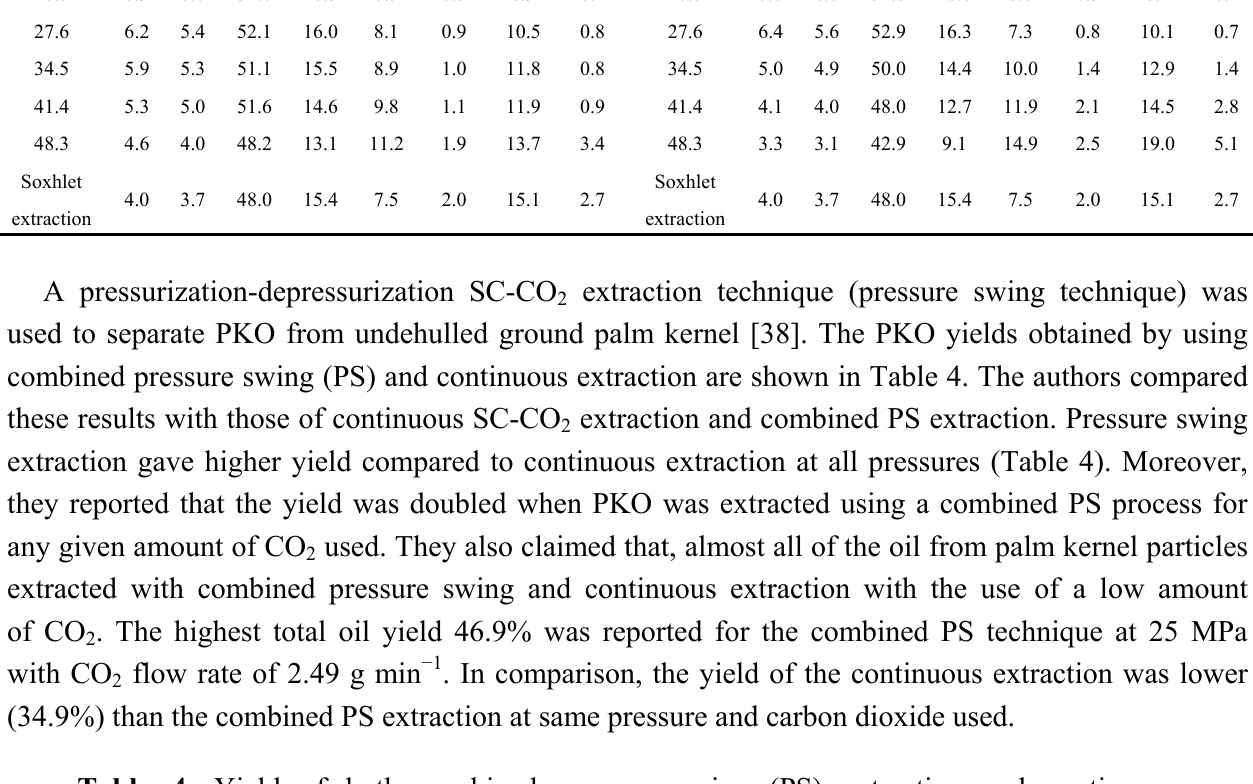
Table 4. Yield of both combined pressure swing (PS) extraction and continuous extractions at various time intervals up to total extraction times of 150 min. Reproduced with permission from Elsevier